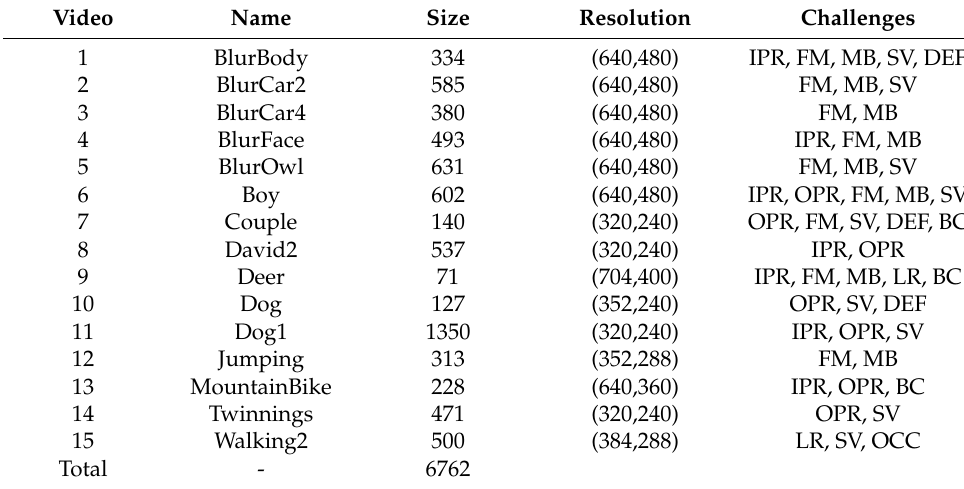
Table 2. The features of the